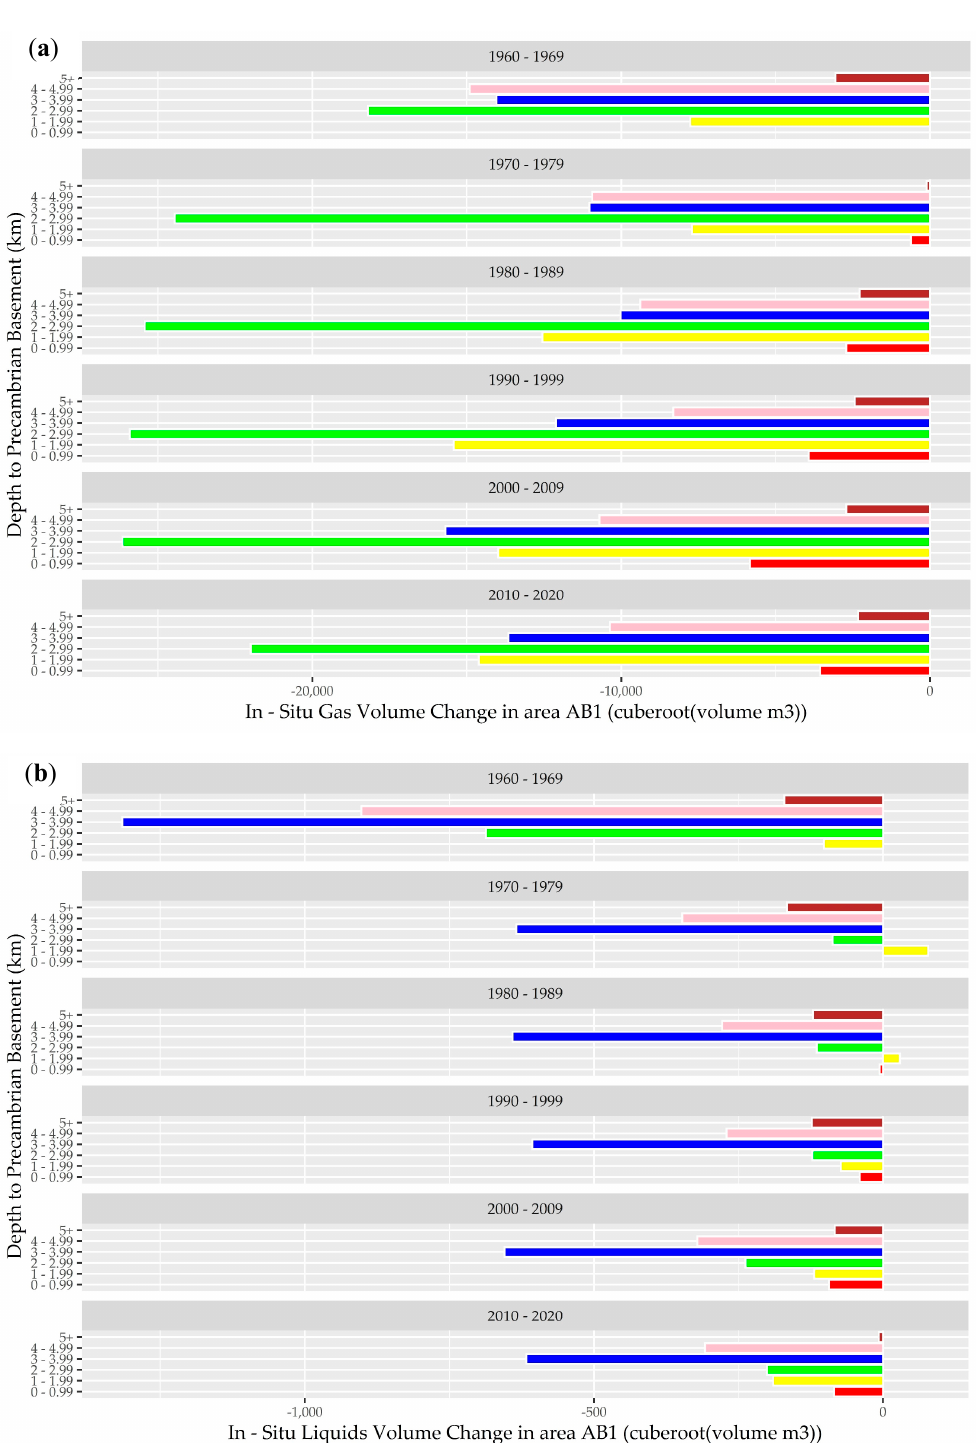
Figure 3. Calculated net in situ ( a ) gas and ( b ) liquid balance for area AB1 over the period January 1960–December 2020. Red bars: <1 km depth from Precambrian basement; Yellow bars: 1–2 km depth from Precambrian basement; Green bars: 2–3 km depth from Precambrian basement; Blue bars: 3–4 km frm Precambrian basement; Pink bars: 4–5 km depth from Precambrian basement; Brown bars: 5+ km depth from Precambrian basement. Source data extracted from geoLOGIC Systems databases ©